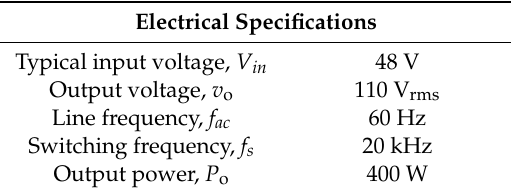
Table 1. Electrical specifications of the proposed inverter.